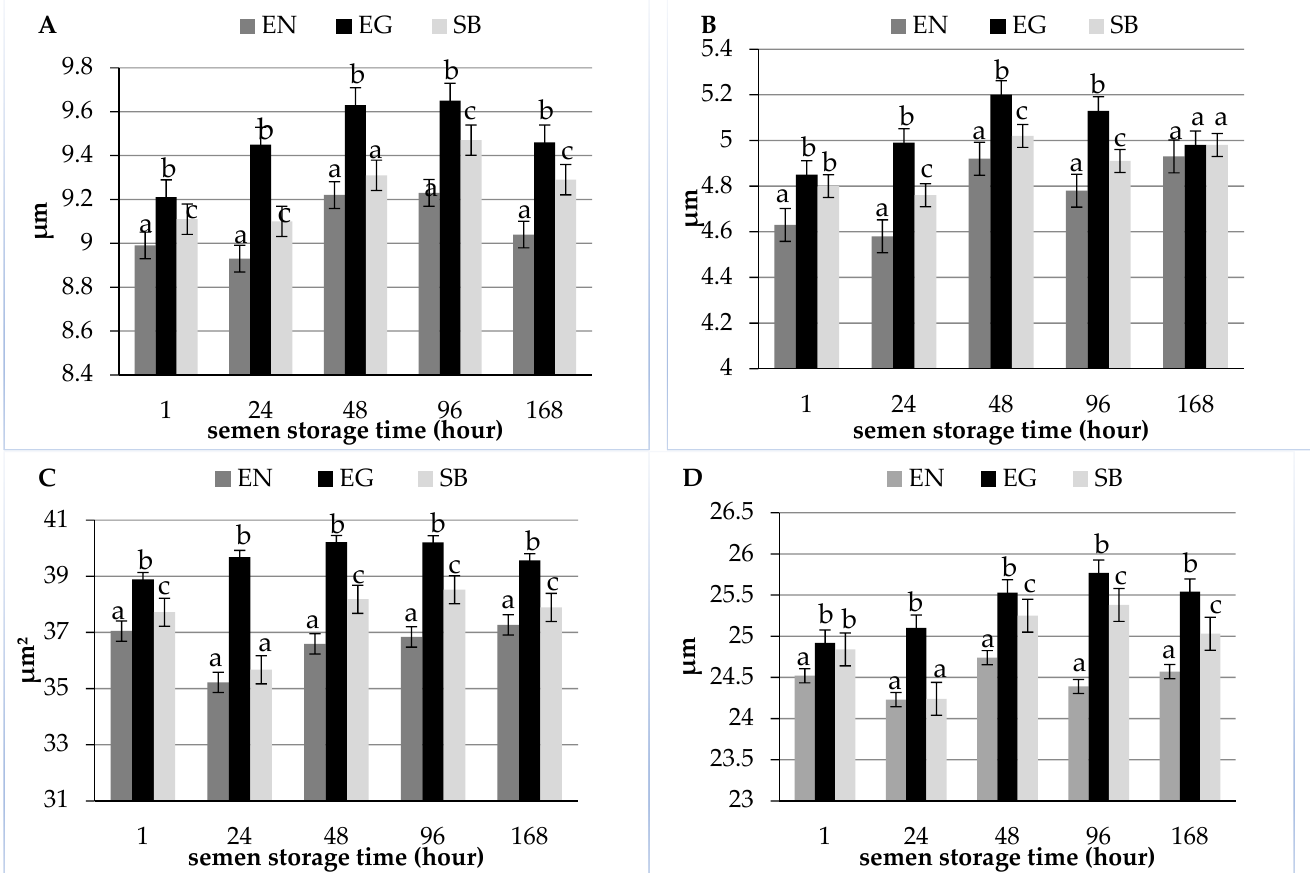
Figure 1. Morphometric dimensions of the heads of sperm stained by the eosin-nigrosin (EN), eosin-gentian (EG), and SpermBlue (SB) methods depending on semen storage time (( A )—length, ( B )—width, ( C )—area, ( D )—perimeter). Bars with different letters mean statistically significant values ( p ≤ 0.05).